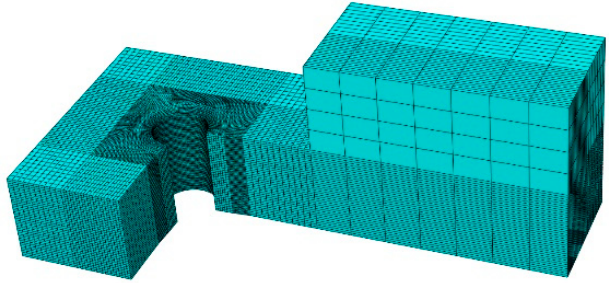
Figure 9. Cross section of the finite element model of the plate.